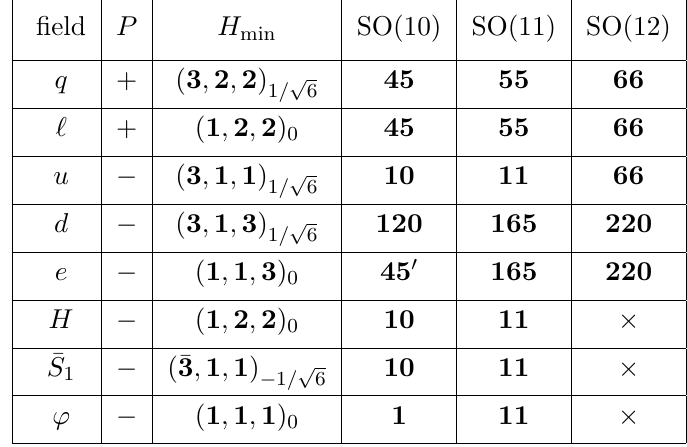
Table 1 . Embedding of the composite partners of the elementary fermions, from H min up to SO(12). In the last three lines of the table we show the NGBs that transform with the fundamental representation of